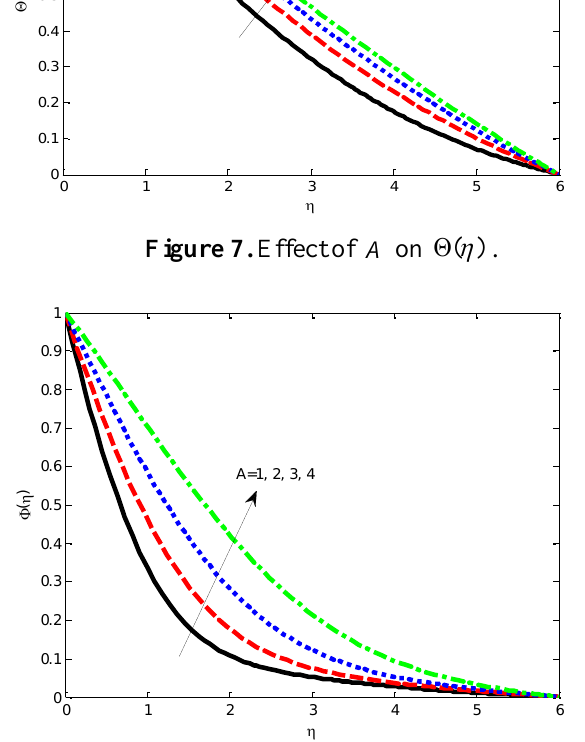
Figure 8. Effect of A on ( ) 